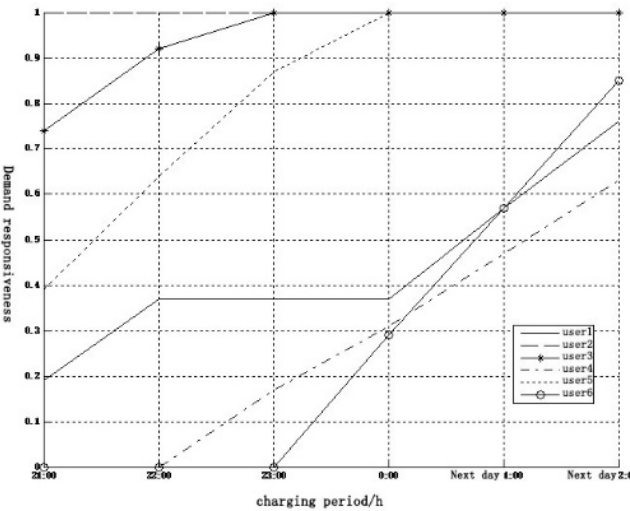
Figure 7. Distribution diagram of response degree of users’ time demand from 21:00 to 2:00 the next day.